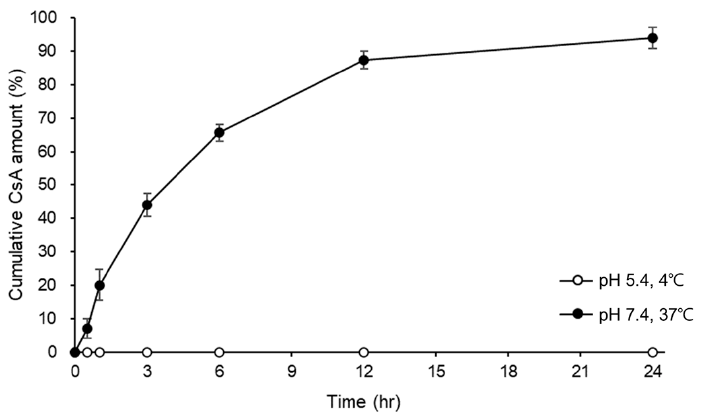
Figure 1. Cyclosporine A (CsA) release profile for pH-responsive CsA-loaded contact lenses in pH 5.4 at 4 ◦ C or in pH 7.4 at 37 ◦ C. All data are presented as mean ±